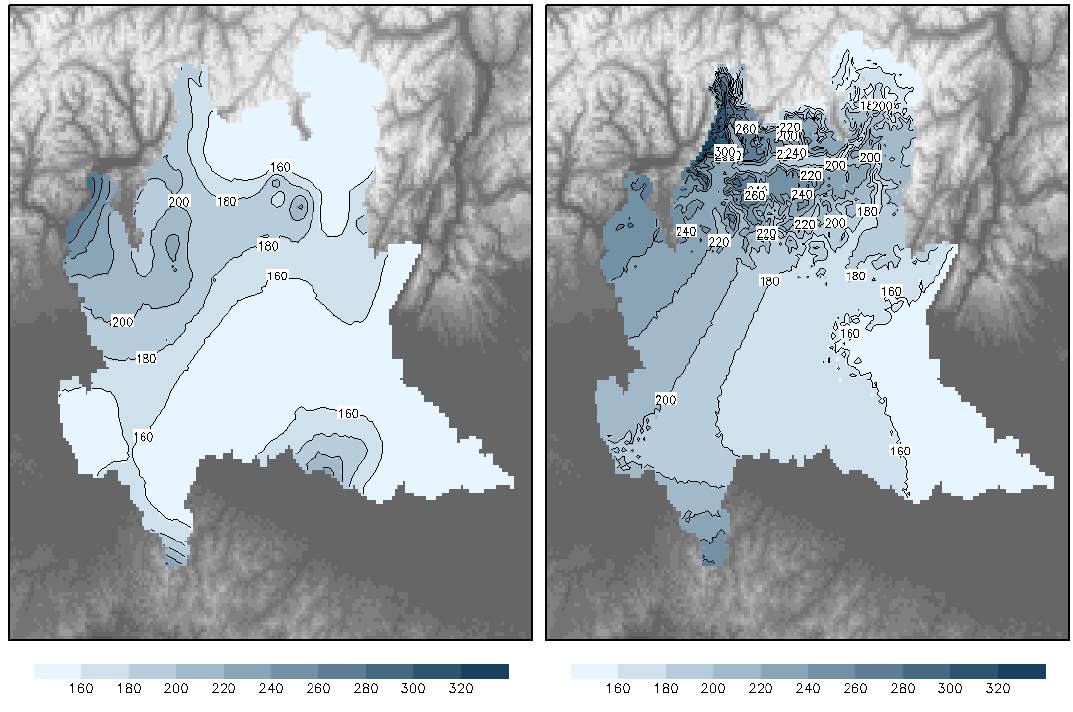
Fig. 9. Same as Fig. 7, but for the event duration D = 24 h.